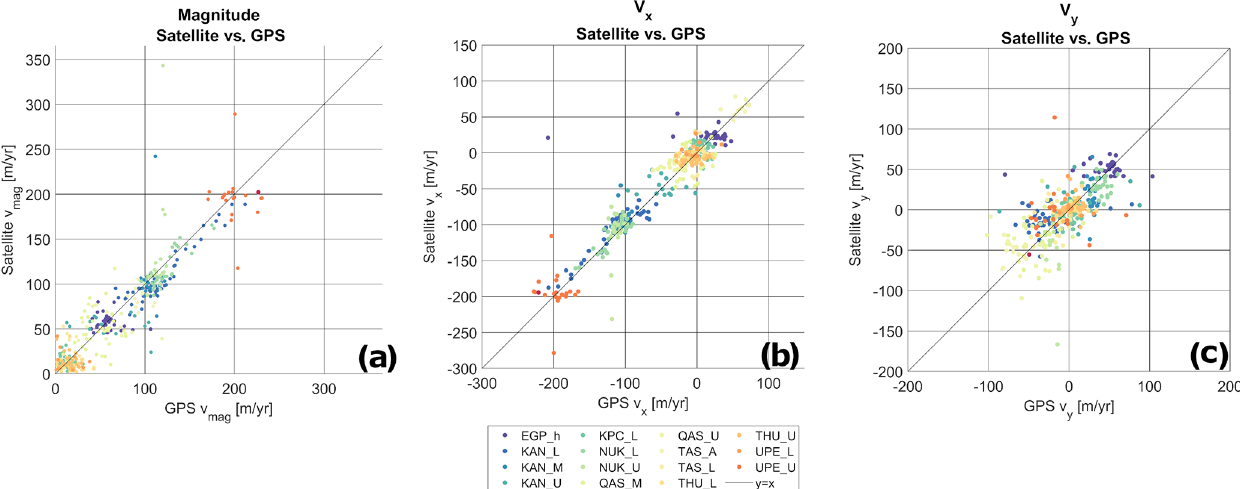
Figure 13. Scatter plots of PROMICE GPS ice velocity vs. PROMICE Ice Velocity. (a) Scatter plot of the magnitude of the velocity. (b) Scatter plot of the v x component. (c) Scatter plot of the v y component.